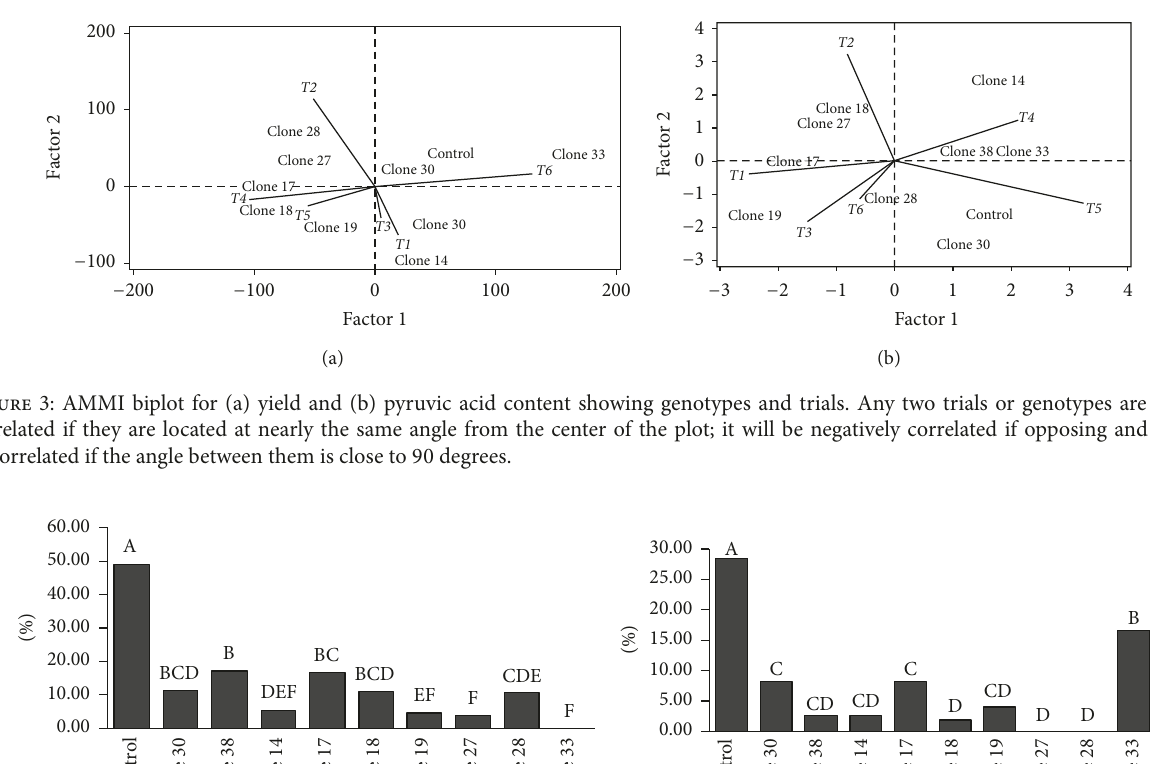
were Clone 30 and Clone 38 showing 11% and 17% of disease severity, respectively (Figure 4(a)). The use of